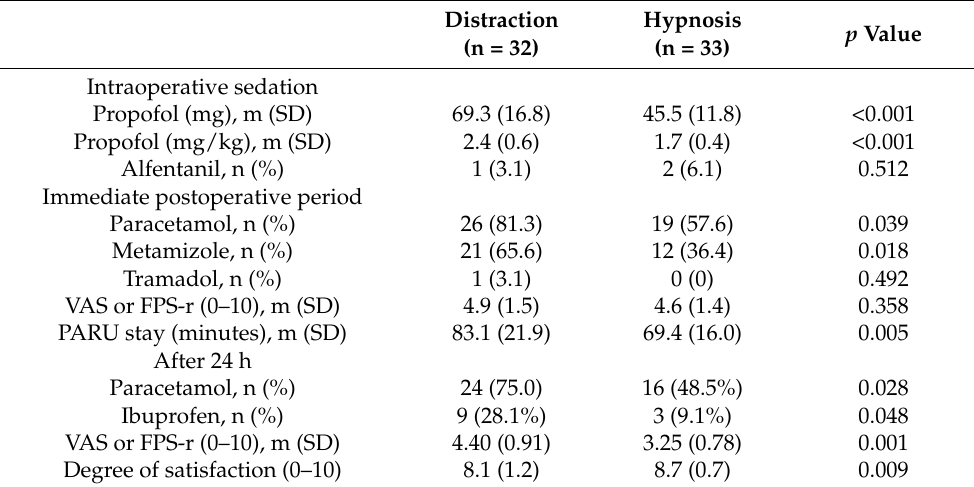
Table 2. Outcome measurements and comparison between